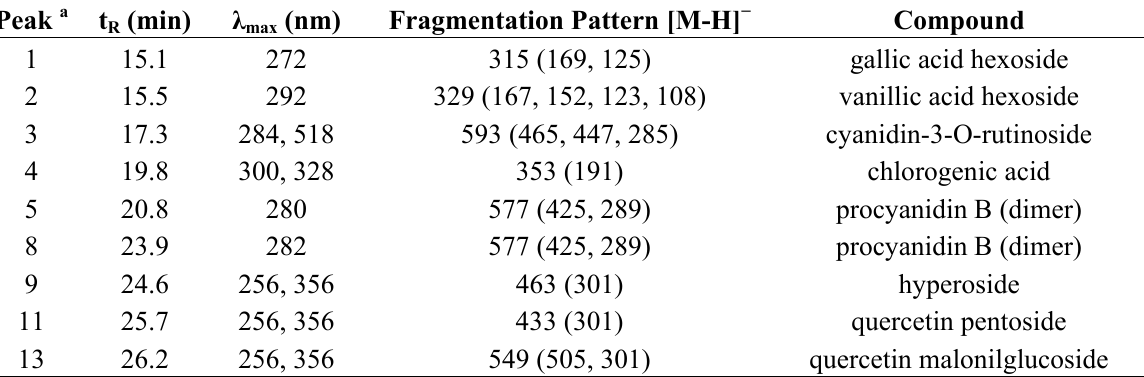
Table 5. Retention times, UV-Vis, and mass spectral data of phenolic compounds in crude extract of black cherry flesh.